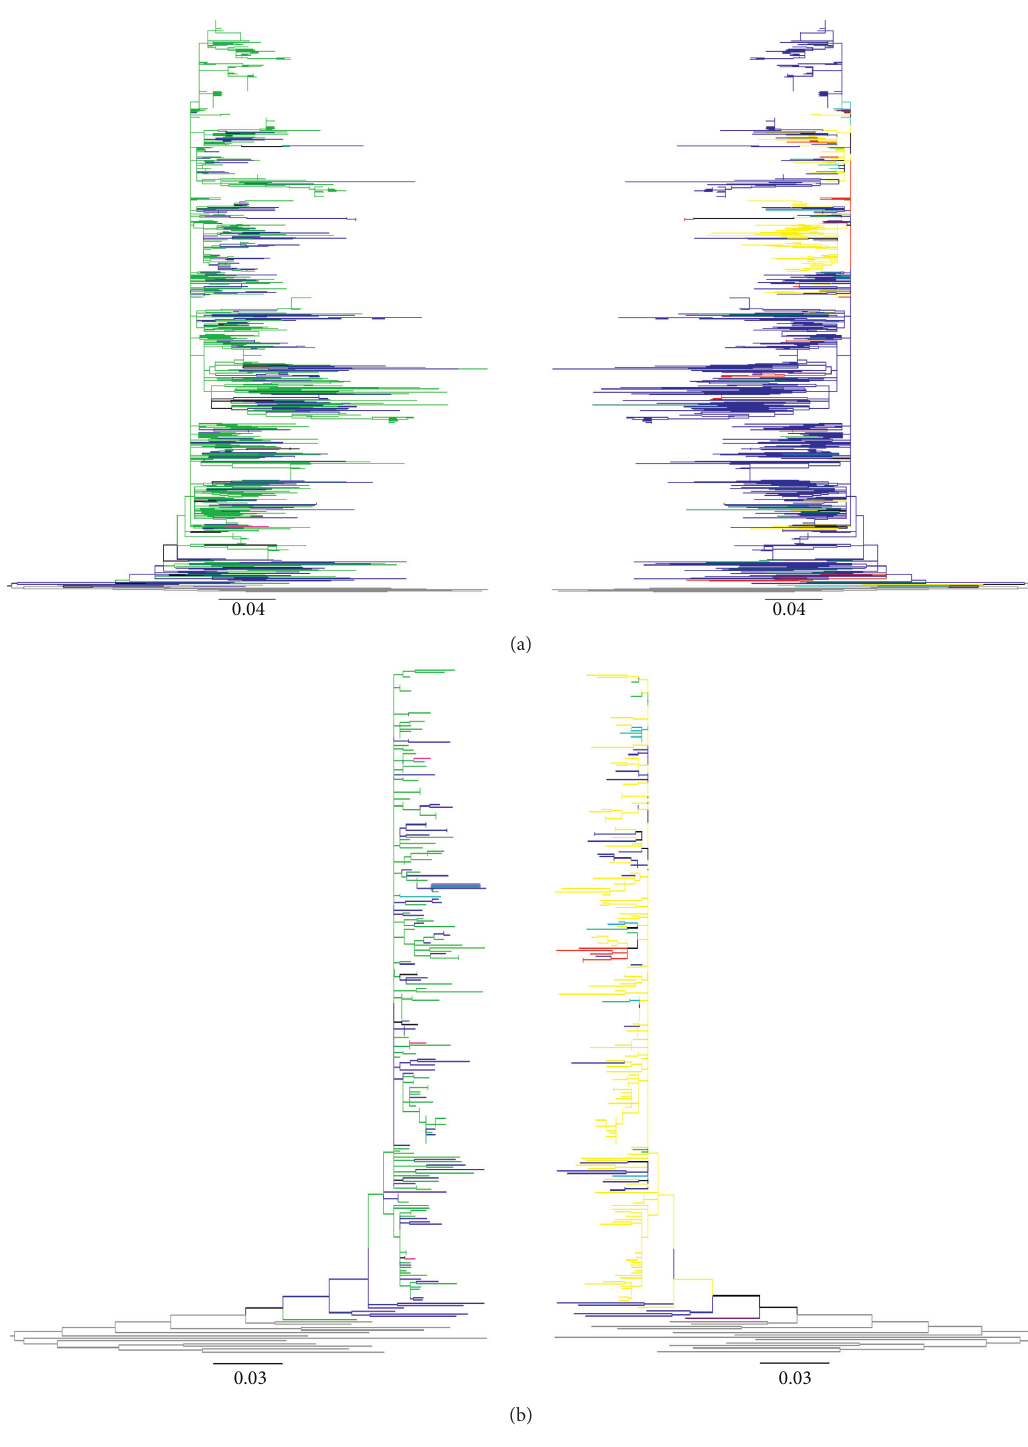
Figure 5: Analysis of HIV transmission routes in FSU countries: HIV-1 subtype A env (a) or gag (b) sequences from FSU countries were analysed for high-risk behavior. To analyse risk behavior in the context of location, the two versions of the same tree, with branches color- coded for the country of origin (left) or the associated risk group (right), are juxtaposed. Only sequences with recorded high-risk labels were included in this analysis. Risk behavior information for each sequence was obtained from HIV Los Alamos Database. For the tree on the right, the colors dark blue, teal, turquoise, pink, green, olive, red, neon, orange, and grey branches indicate, respectively, heterosexual, sexual transmission (unspecified type), MSM, mother-to-child, PWID, blood transfusion, homosexual, sex worker, bisexual, and reference se- quences. For the tree on the left, the color key is the same as for Figure